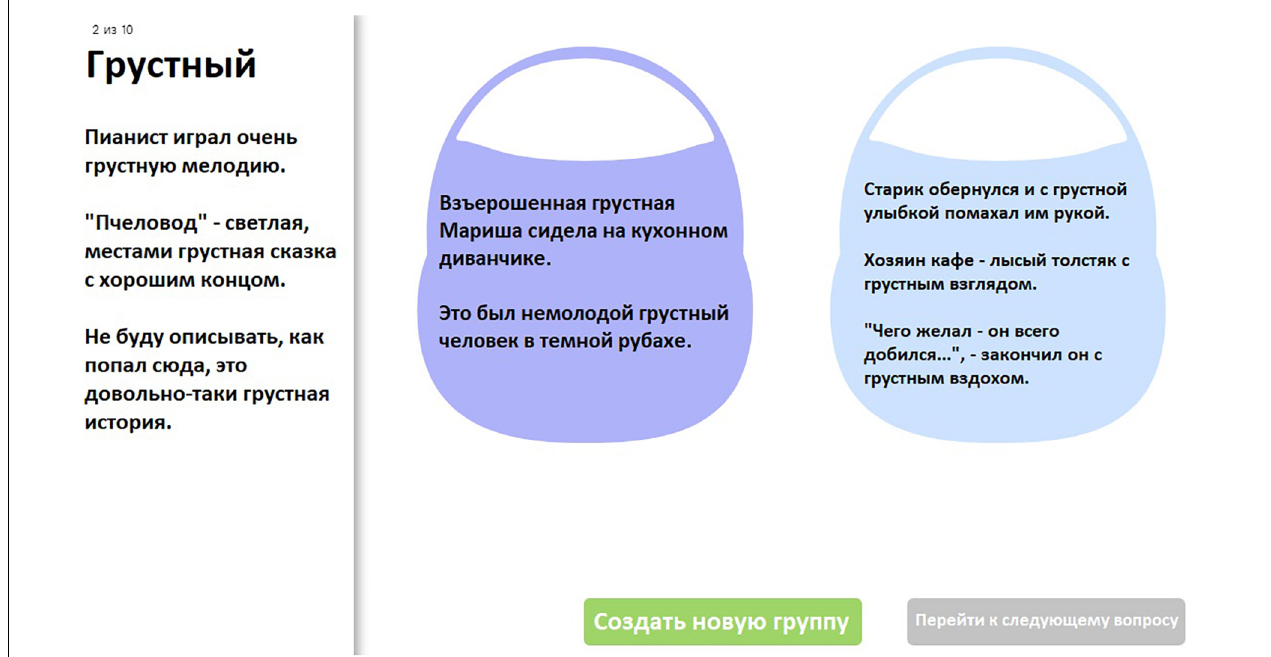
FIGURE 1 | An example trial with the word grustnyj (“sad”). In the left column, all phrases that should be sorted are listed. Below are the two buttons “Create a new group” and “Switch to the next trial.” Participants were not allowed to switch to the next trial until they finished sorting all the phrases from the left